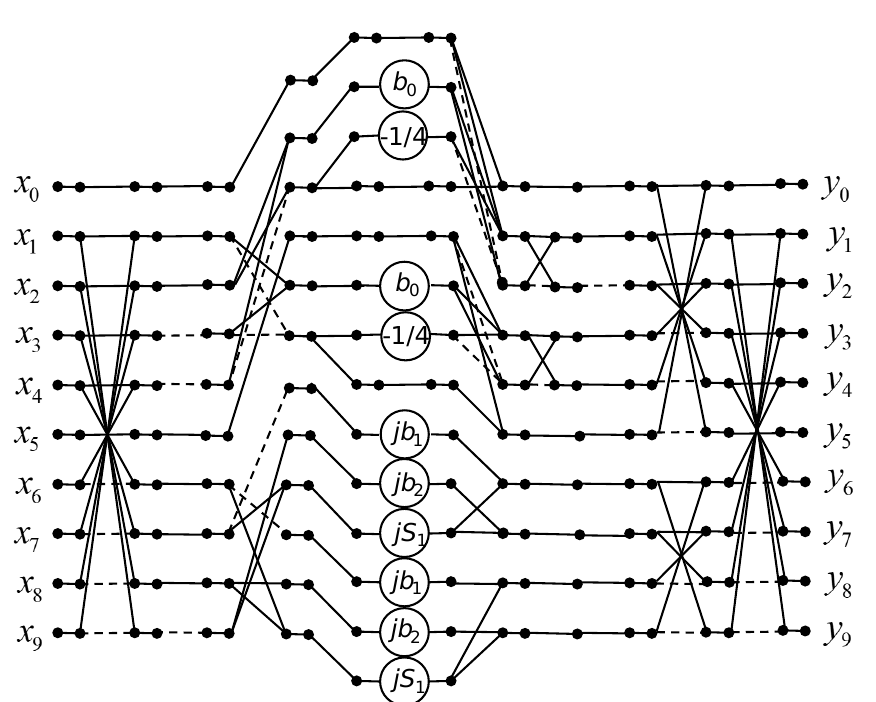
Figure 1. The signal flow graph of the proposed algorithm for a 10-point DFT, where b 0 = ( C 2 + C 1 ) /2 = 0.5590, b 1 = S 2 + S 1 = 1.5388, and b 2 = S 2 − S 1 = 0.3633.